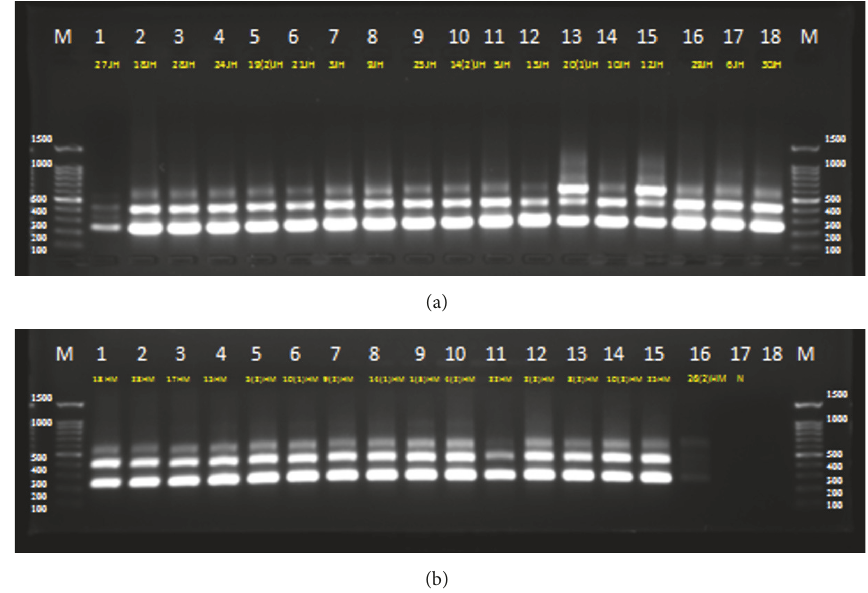
Figure 2: Amplification of 16S–23S internal transcribed spacer region using S-D-Bact-1494 and L-D-Bact-0035 primers. Lanes 1–18 in (a) represent samples obtained from Jordan Al-Hemma. Lanes 1–16 in (b) represent samples from Maain and Zara hot springs; Lane 17 represent a negative control. M; molecular marker.